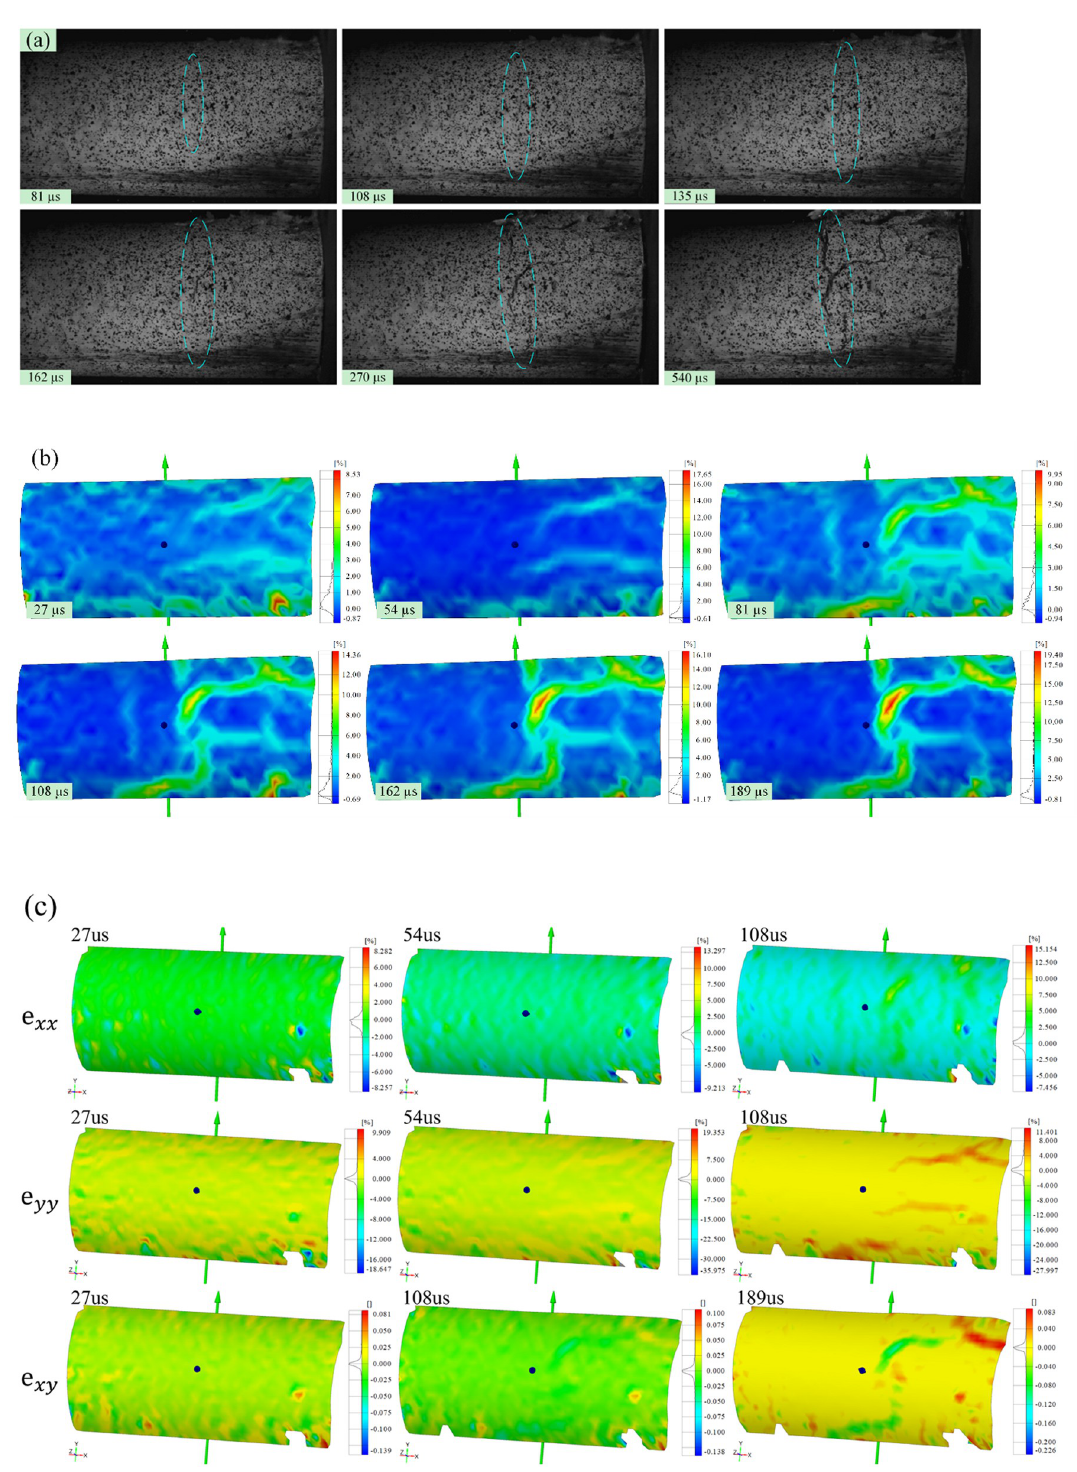
Fig 5. Images of the evolution of visible cracks and strain fields in different directions at a velocity of 25.0 m/s (the right face is the impacting face). (a) the high-speed images; (b) the maximum principal strain; (c) the axial (e xx ), vertical (e yy ) and shear (e xy ) strain.